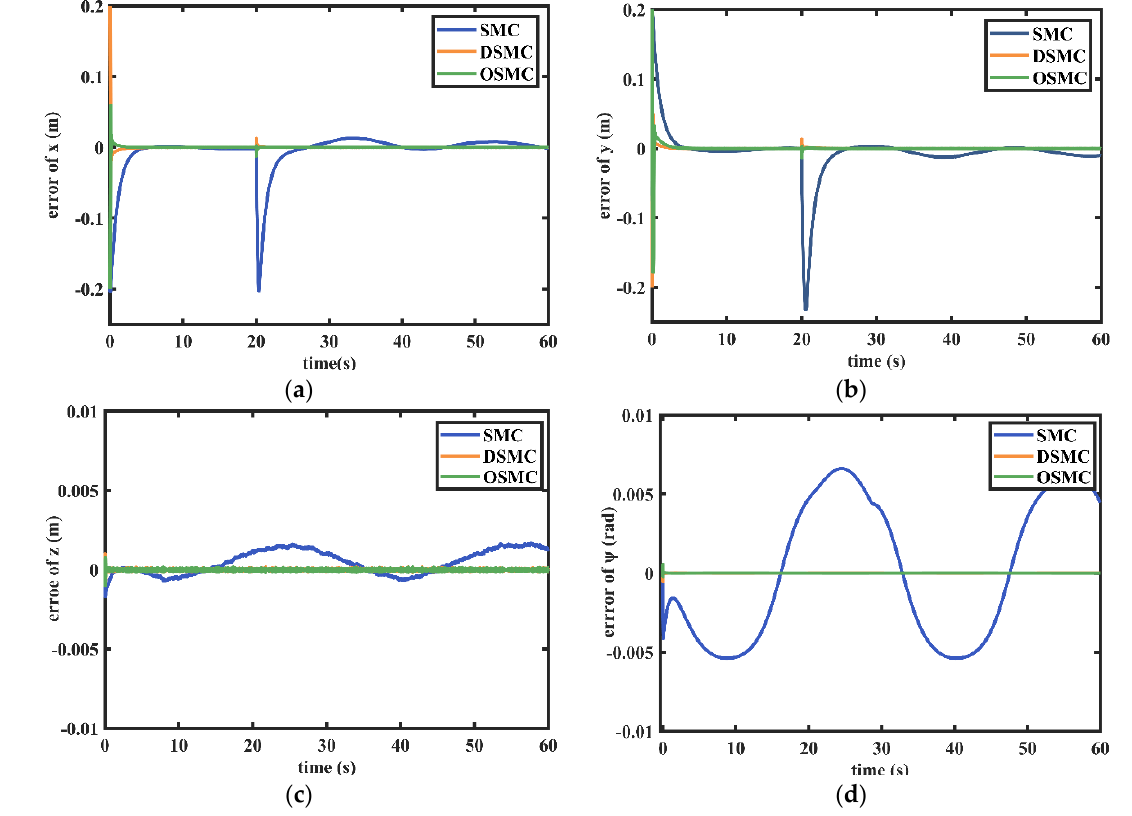
Figure 5. Tracking errors for the position and attitude of the ROV associated with the three control schemes: ( a ) tracking error of position x; ( b ) tracking error of position y; ( c ) tracking error of position z; and ( d ) tracking error of attitude Ψ .